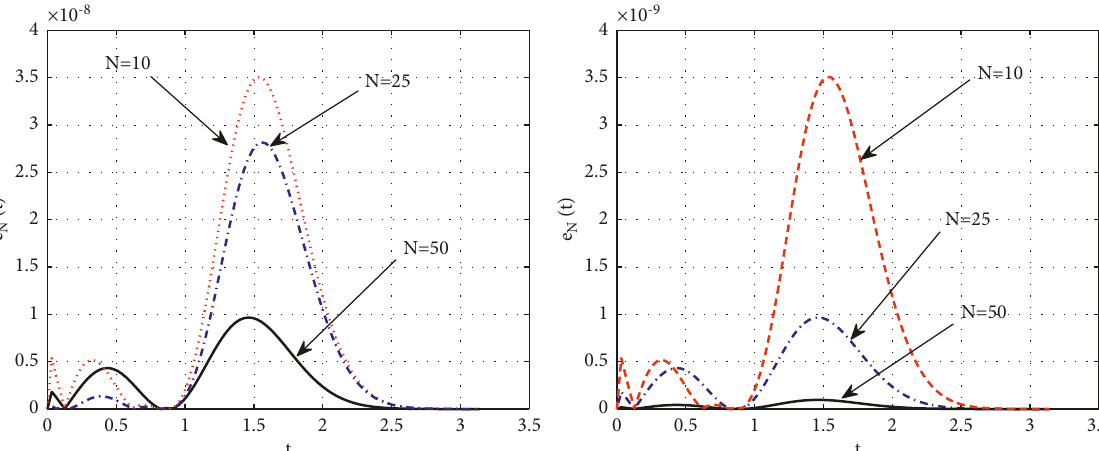
Figure 4: The absolute error function graph by using the proposed method for Example 1 with different values of N